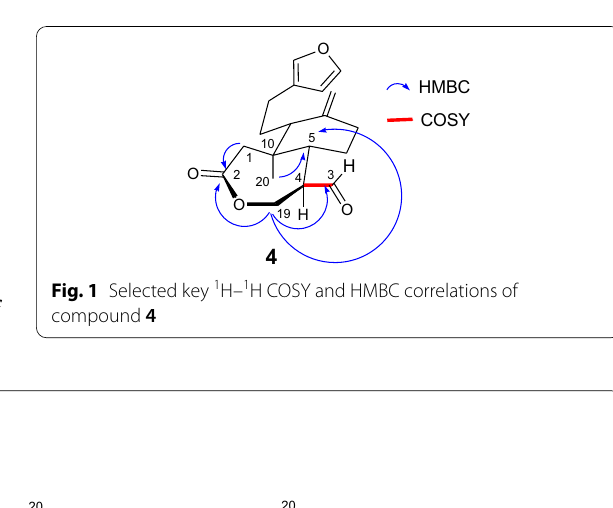
correlations confirm the formation of the seven members lactone of structure 4 (Fig. 1).